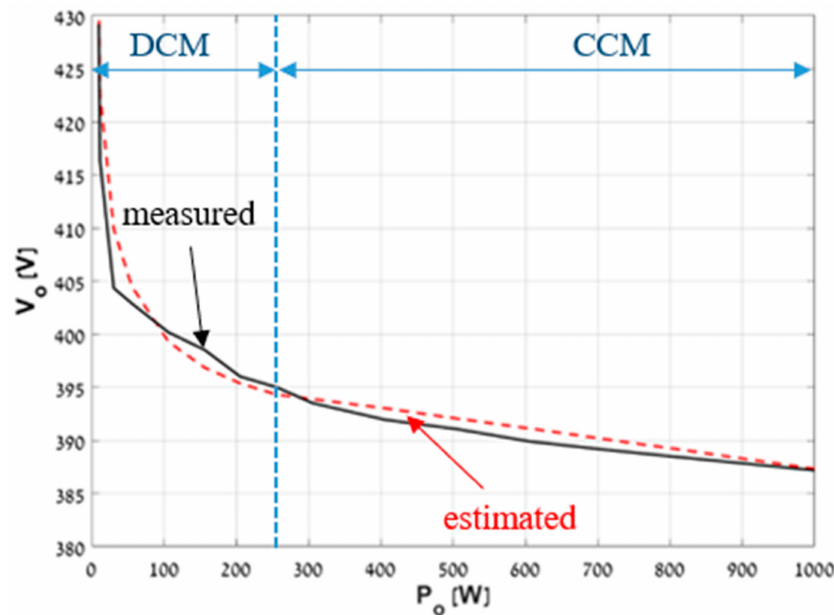
Figure 19. IWPT link measured and estimated output DC voltage versus load power.